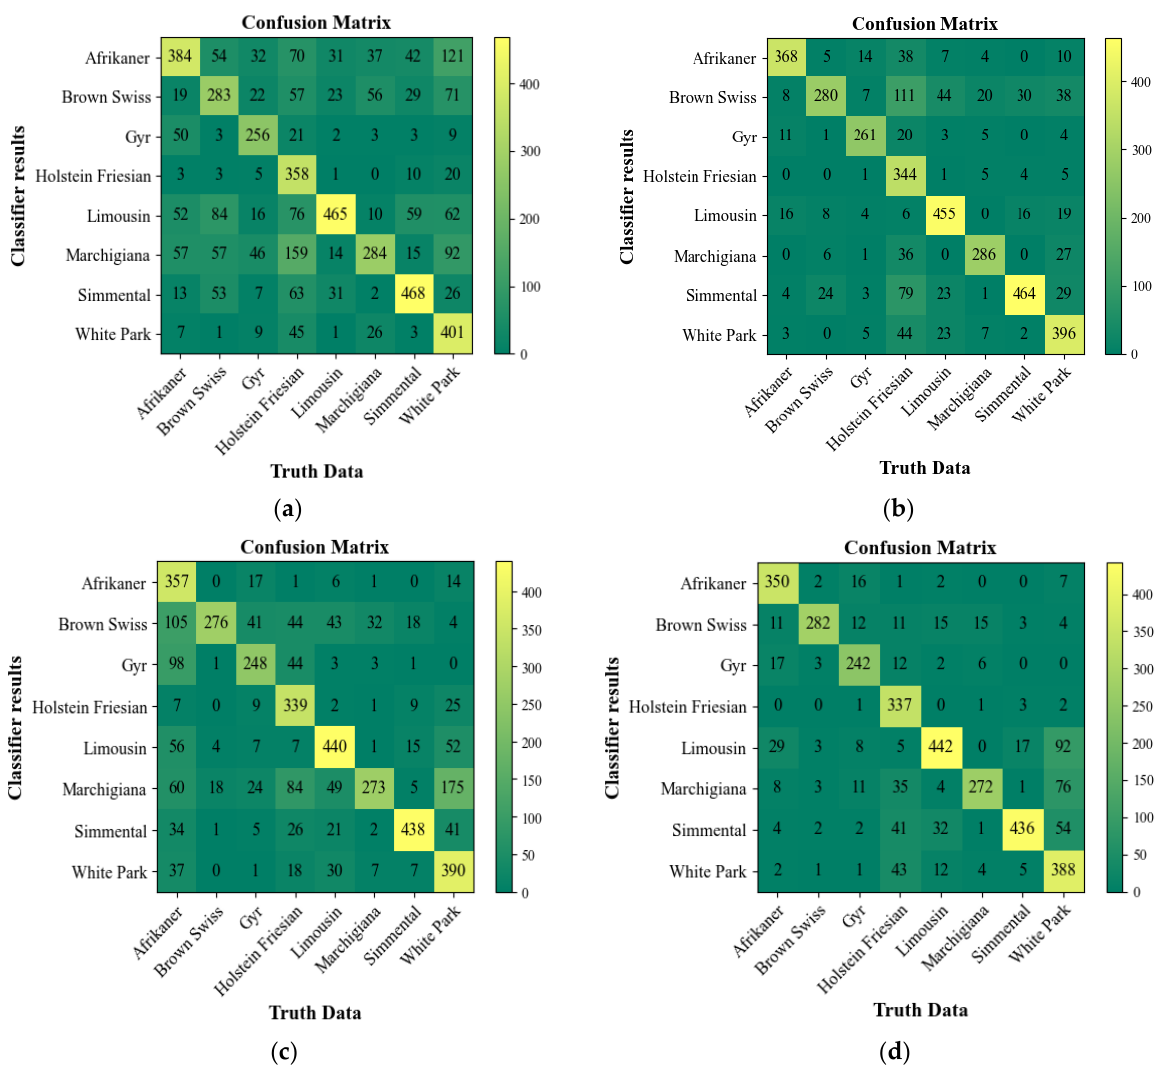
( d ) Figure 14. PR curves acquired with network size and IoU _threshold ( a ) 416 × 416, 0.50 ( b ) 416 × 416, 0.75 ( c ) 608 × 608, 0.50 ( d ) 608 × 608, 0.75. 4.2. Confusion Matrix As discussed earlier, the image resolution and IoU _threshold significantly influence